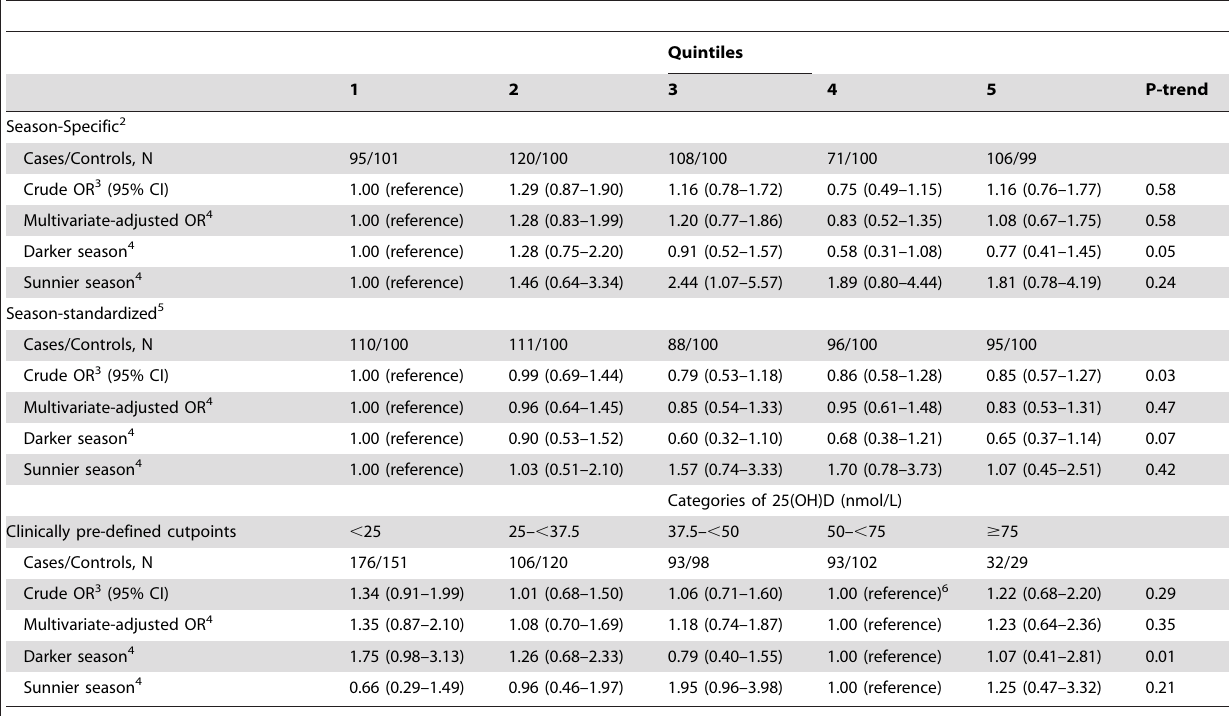
Table 2. Association between serum 25(OH)D and risk of lung cancer, presented as season-specific quintiles, season-standardized quintiles, and clinically pre-defined cutpoints, and stratified on season of blood collection.